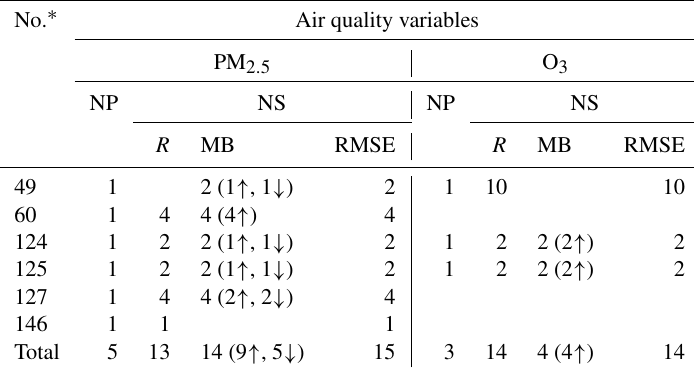
Table B5. The compiled number of publications (NP) and number of samples (NS) for papers simultaneously providing the statistical indices (SIs) of air quality variables simulated by coupled models (WRF-Chem, WRF-CMAQ, GRAPES-CUACE, WRF-NAQPMS, and GATOR-GCMOM) with and without